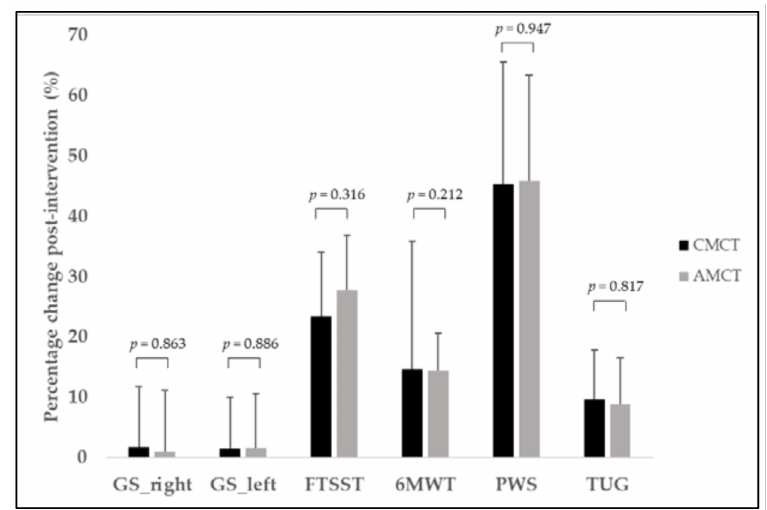
Figure 2. Percentage change in physical function tests following CMCT (solid bar) and AMCT (gray bar). GS indicates grip strength; FTSST, lower limb strength; 6MWT, 6 min walk test; PWS, preferred walking speed; TUG, timed up and go; CMCT, continuous multicomponent training; AMCT, accumulated multicomponent training. For GS, 6MWT, and PWS, the greater the percentage change, the greater the improvement. For FTSST and TUG, the lower the percentage change, the greater the improvement.